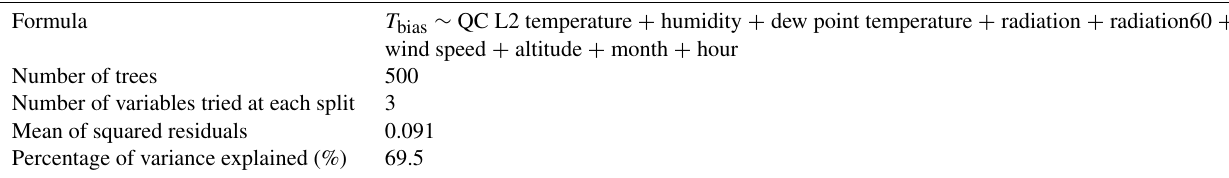
Table 9. Statistical details of the RF temperature bias prediction model.